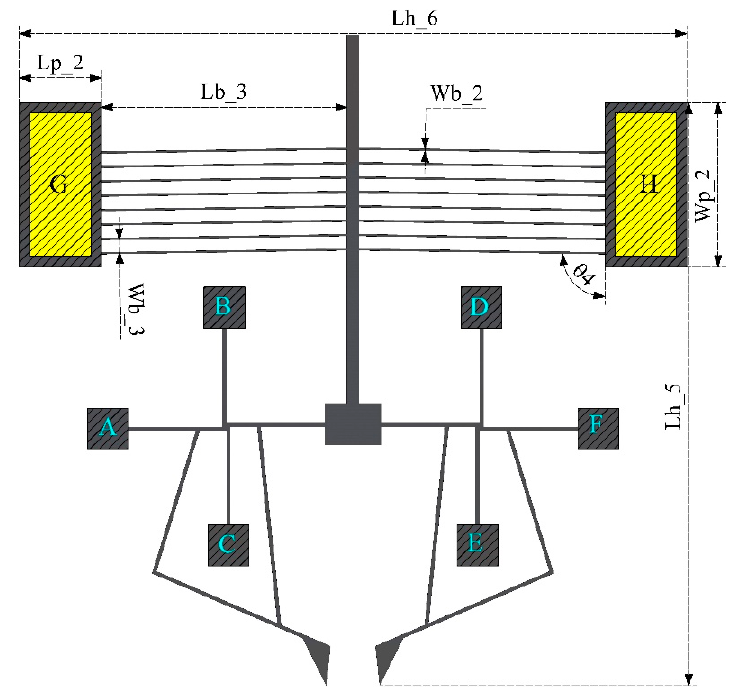
Figure 2. Microgripper Model 2, electrochemically actuated by chevron.